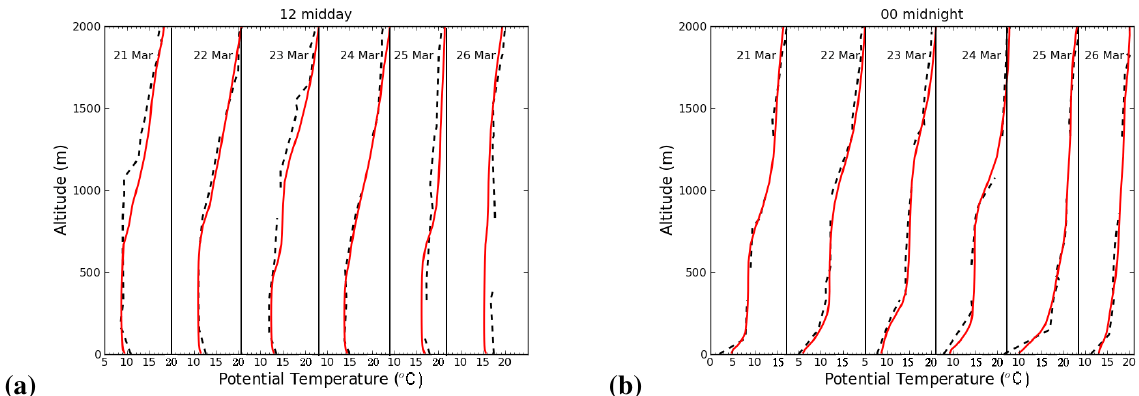
Fig. 6. Vertical profiles of potential temperature (in ◦ C) above the Trappes location for 12:00 UT (a) and 00:00 UT (b) for the measurements (black dashed lines) and REF simulations (solid red lines).